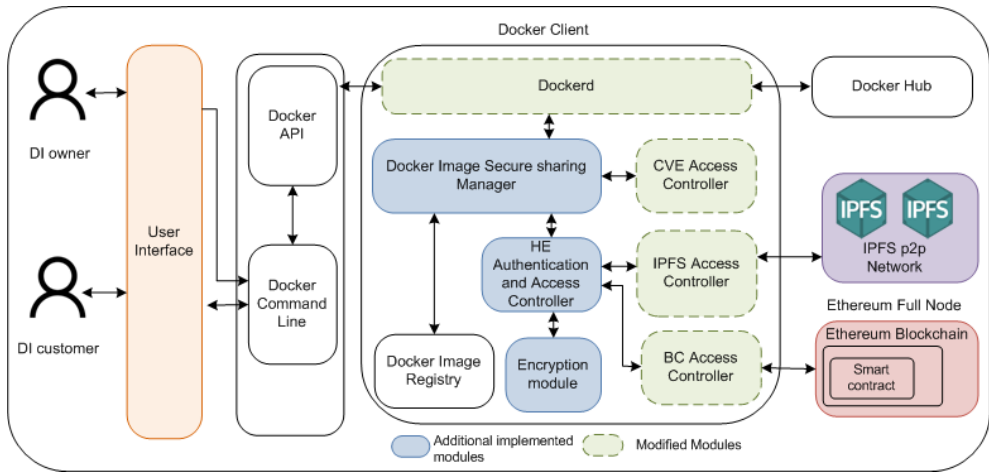
Figure 1. SeDIS-HEB System